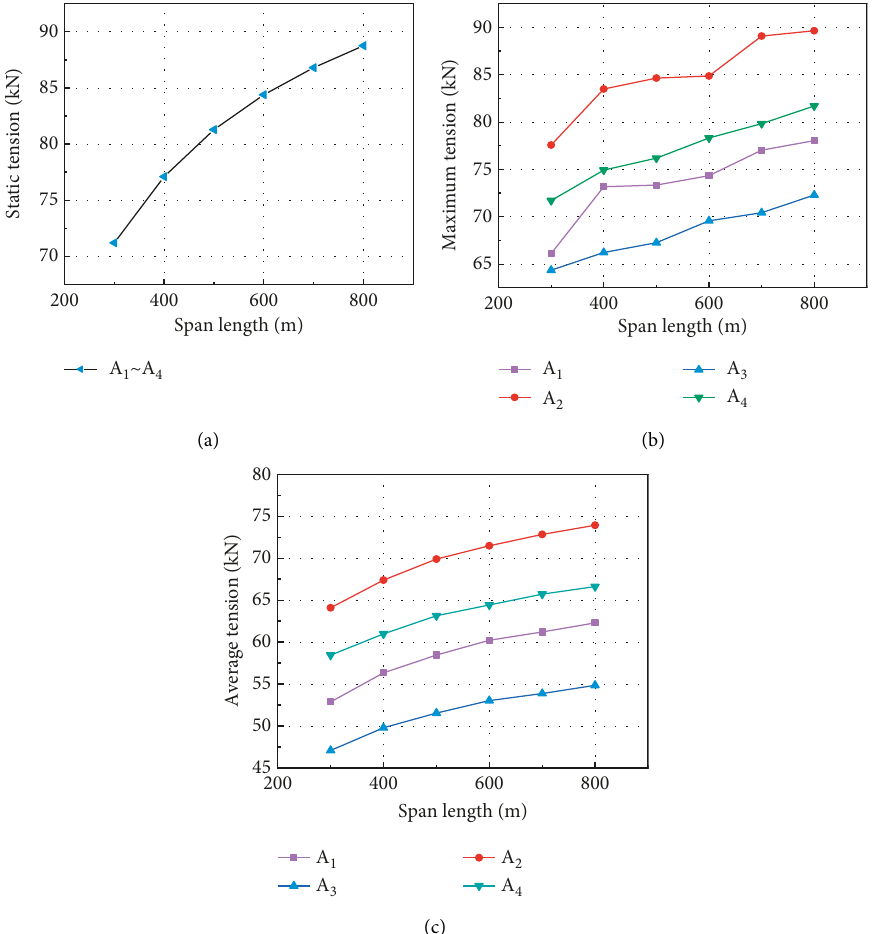
Figure 11: Relationship between span length and conductor hanging point tension: (a) Static tension, (b) Maximum tension, (c) Average